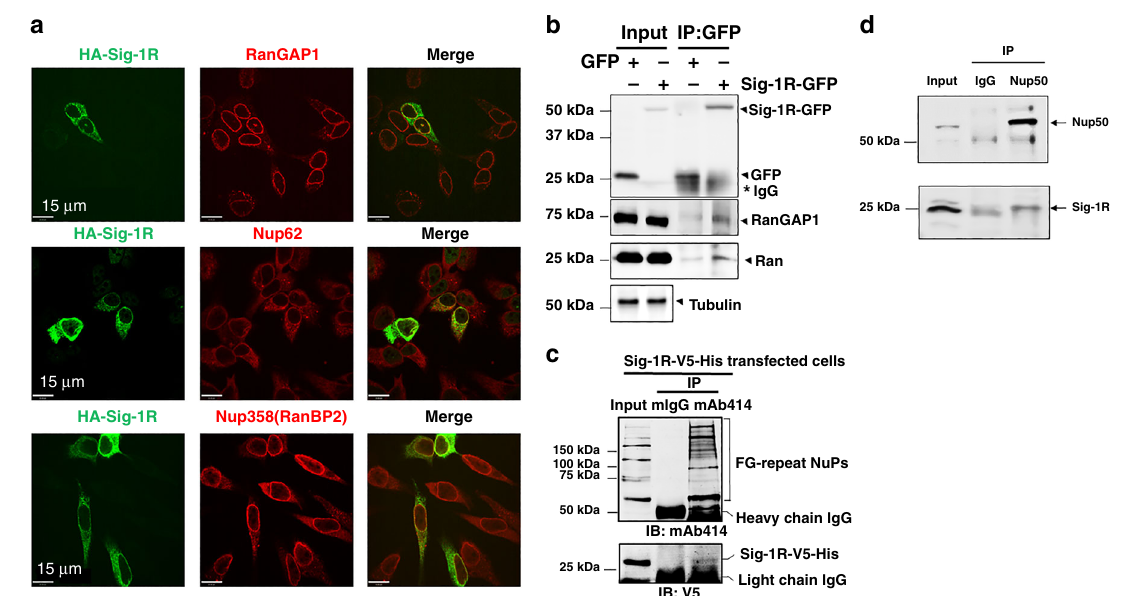
Fig. 1 Localization and association of HA-tagged Sig-1R, RanGAP1, and a nuclear pore complex proteins Nup62 in HeLa cells. a Immunohistochemistry followed by confocal microscopic examination indicates perinuclear colocalizations of immunoreactive HA-tagged Sig-1R (green) with RanGAP (red), Nup62 (red) and Nup358 (red). HeLa cells transiently transfected with human HA-Sig-1R vectors were used. b Coimmunoprecipitation (Co-IP) of GFP- tagged Sig-1R with RanGAP and Ran. HeLa cells were transfected with GFP or GFP-Sig-1R vectors for 24 h before the co-IP experiment. Proteins interacting with GFP (control) or GFP-Sig-1R were detected by western blot. c NuPs ’ interaction with Sig-1R in a co-IP experiment. The mAb414 pulled down FG repeats-containing Nups together with Sig-1R-V5-His which was transfected into HeLa cells. d Nup50 antibody co-IPed with endogenous Sig-1R which in